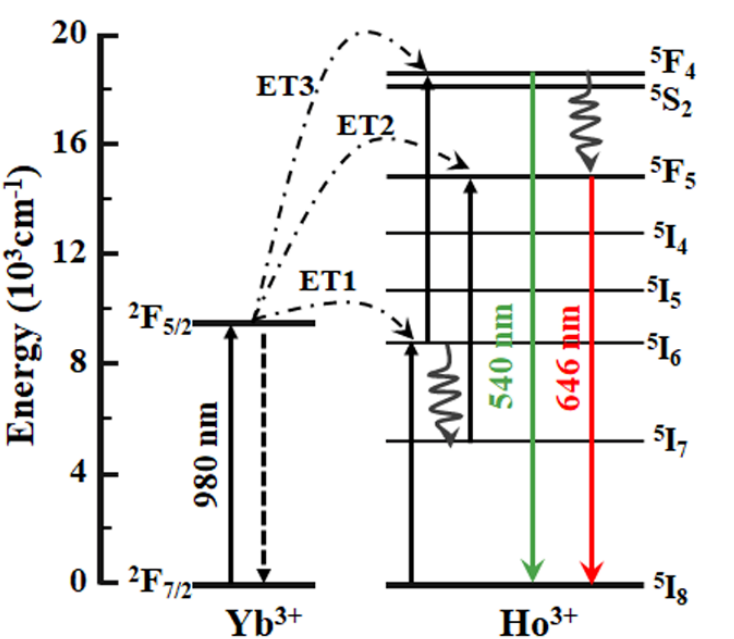
Figure 4. Energy level diagrams of the In:Yb:Ho:LiNbO 3 crystal and the possibly occurring upcon- version